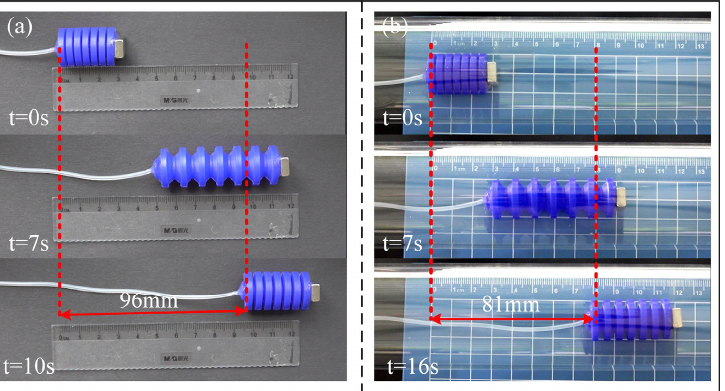
Figure 8. The robot’s motion speed with different surfaces ( a )The robot’s motion speed on cardboard; ( b ) The robot’s motion speed on cardboard acrylic tube.